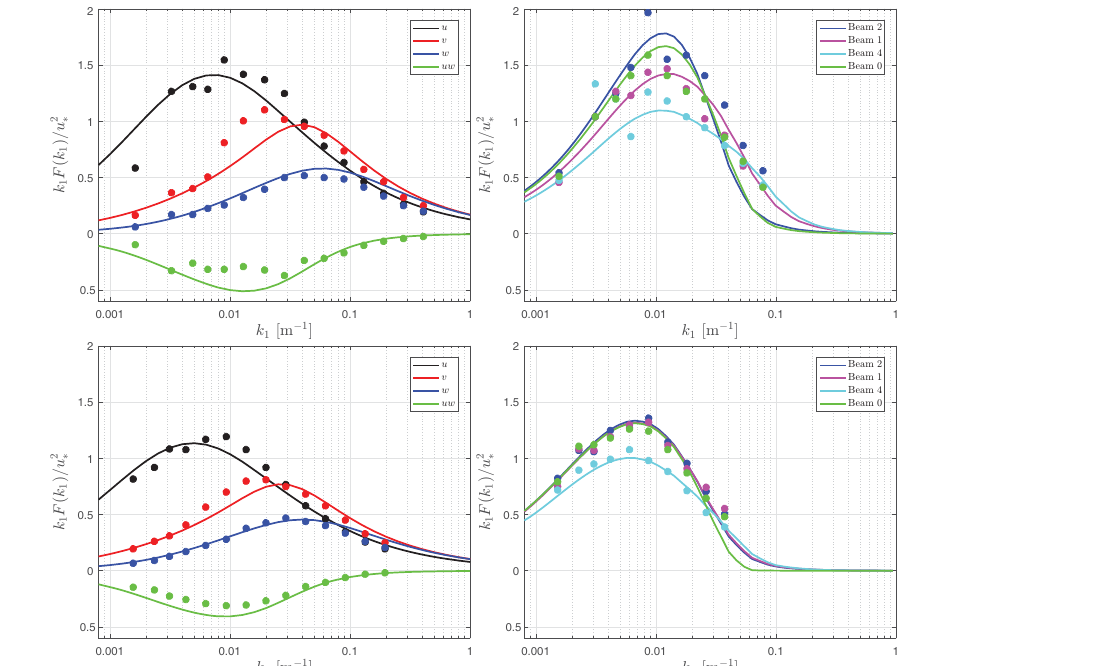
Figure 19. Similar to Fig. 17, but here the top panels show the results for the first wind-speed range (speed 1) and the bottom panels for the last wind-speed range (speed 5).